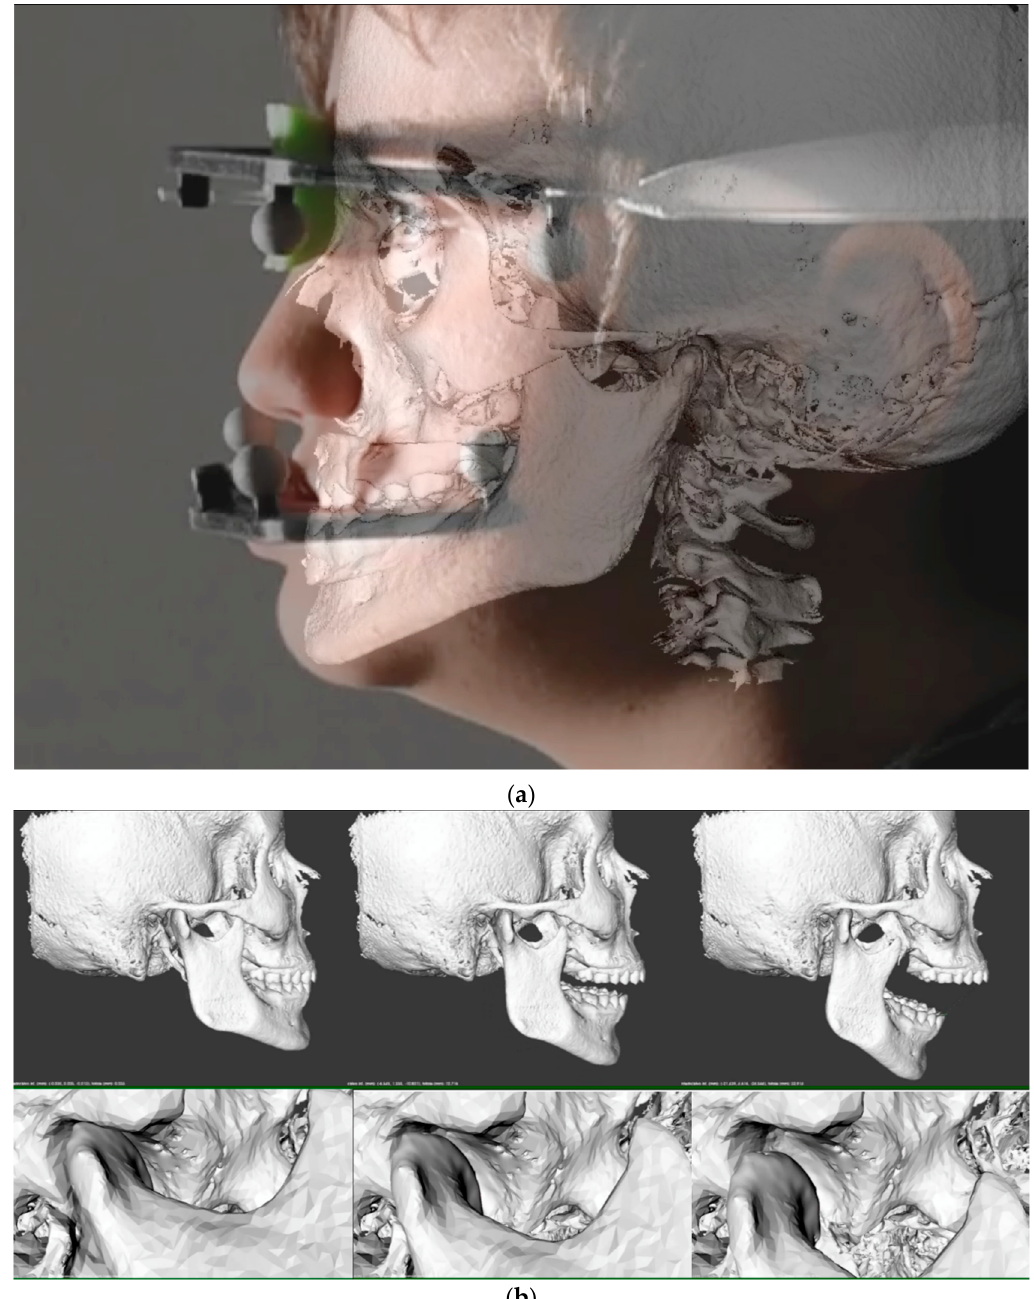
Figure 4. ( a ) The superimposition of the CBCT craniofacial structures with a photograph of the volunteer during the experimental session. ( b ) Combination of CBCT data with the mandibular kinematics recorded during the experiments. The figure shows the position of the condylar head of the mandible in closed (left), light open (middle) and maximal opening position (right).